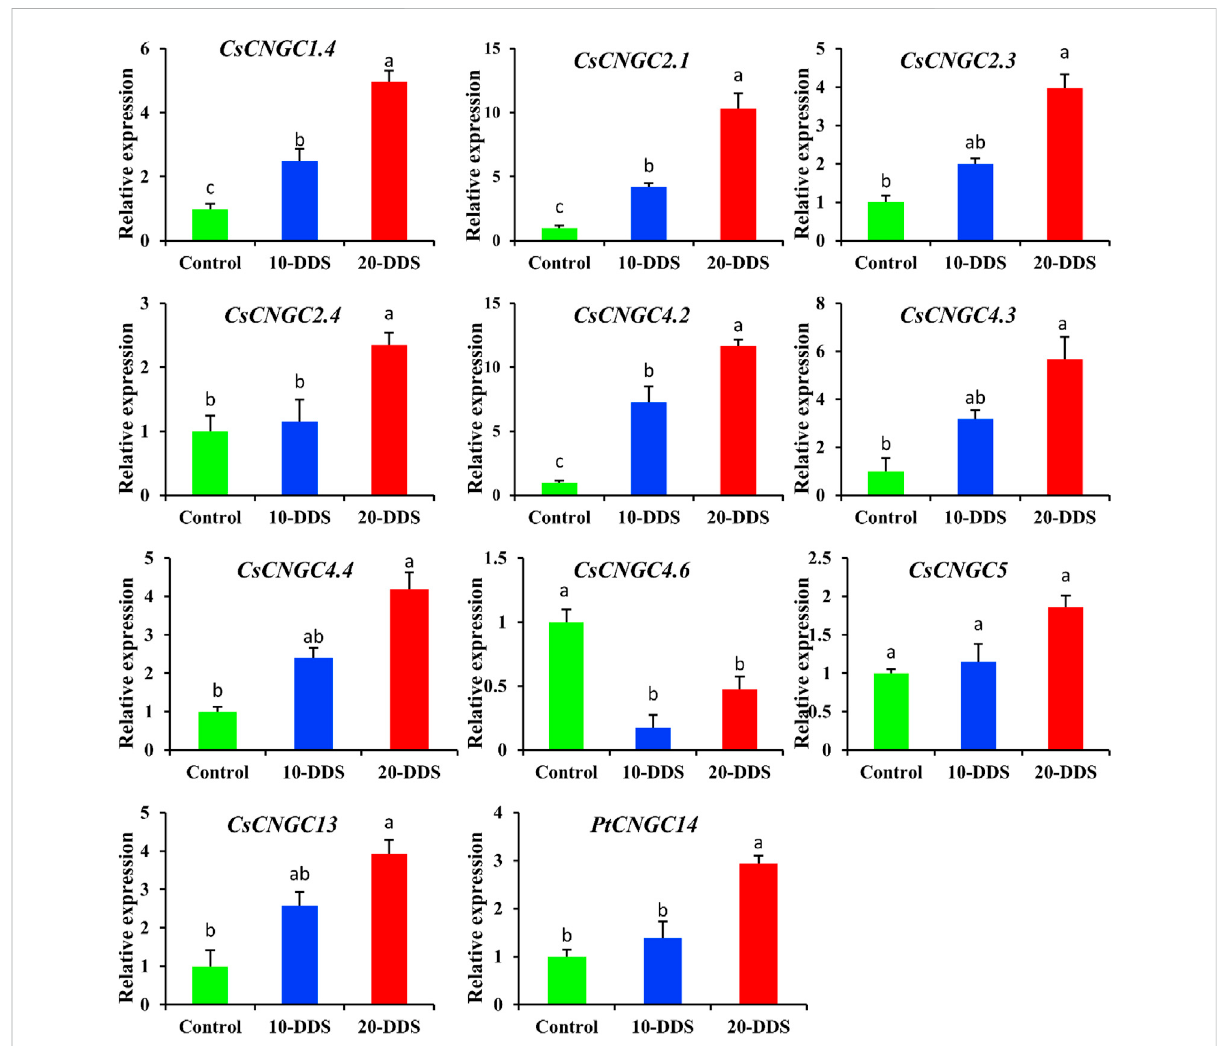
FIGURE 9 The graphs represent the qRT-PCR results of CsCNGC genes under drought stress. 10-DDS: 10 days of drought stress; 20-DDS: 20 days of drought. Each column represents the mean of three biological replicates. The least signi fi cant difference was applied to compare the difference between control and dissimilar drought stress levels at p < 0.05 (a, b,